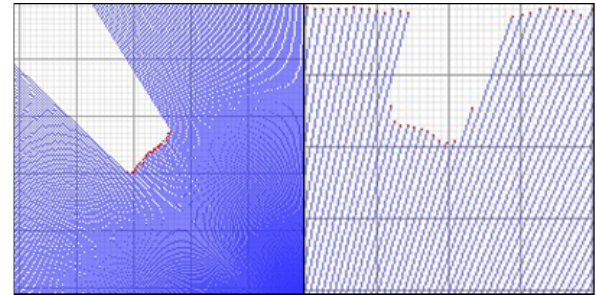
Figure 3: Scan lines plotted for a pole with 110mm diameter at different distances to sensor (left: approx. 500mm, right: approx.